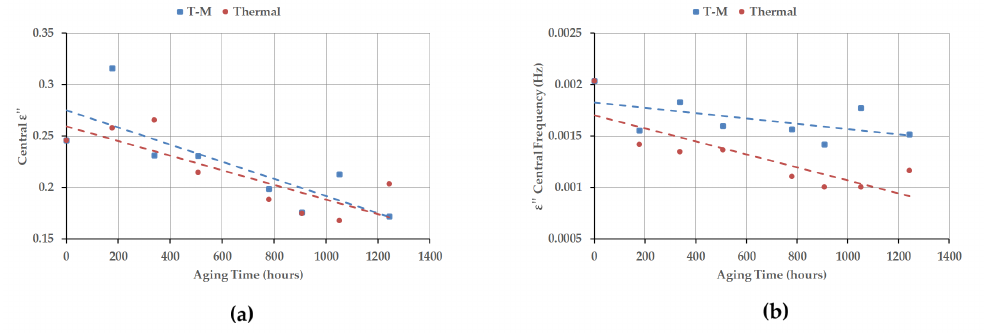
Figure 11. The calculated deducted quantities to characterize the ε (cid:48)(cid:48) ( f ) curves ( a ) central imaginary part of permittivity ( CIP ); ( b ) imaginary part of permittivity’s central frequency ( IPCF